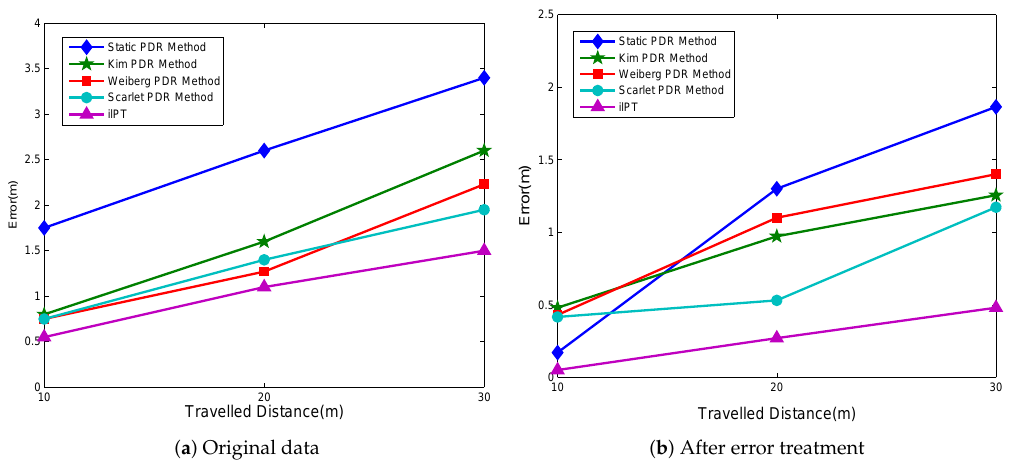
Figure 10. Comparison of tracking accuracy between PDR and